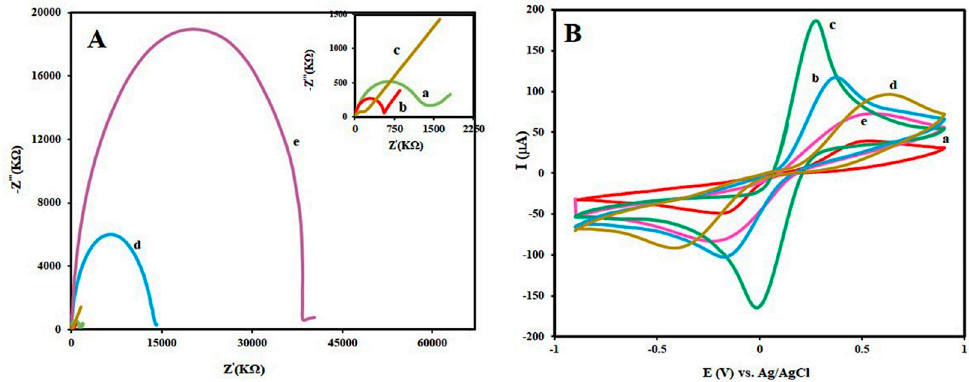
Figure 3. Characterization of different modification steps by ( A ) EIS and ( B ) CV in 0.01 M [Fe(CN) 6 ] 3 − and 0.1 KCl solution at a scan rate of 100 mV s − 1 : bare SPE (a), Fe 3 O 4 @SiO 2 / DABCO / SPE (b), DGNs / Fe 3 O 4 @SiO 2 / DABCO / SPE (c), Apt / DGNs / Fe 3 O 4 @SiO 2 / DABCO / SPE (d), and Trp / hemin / Apt /